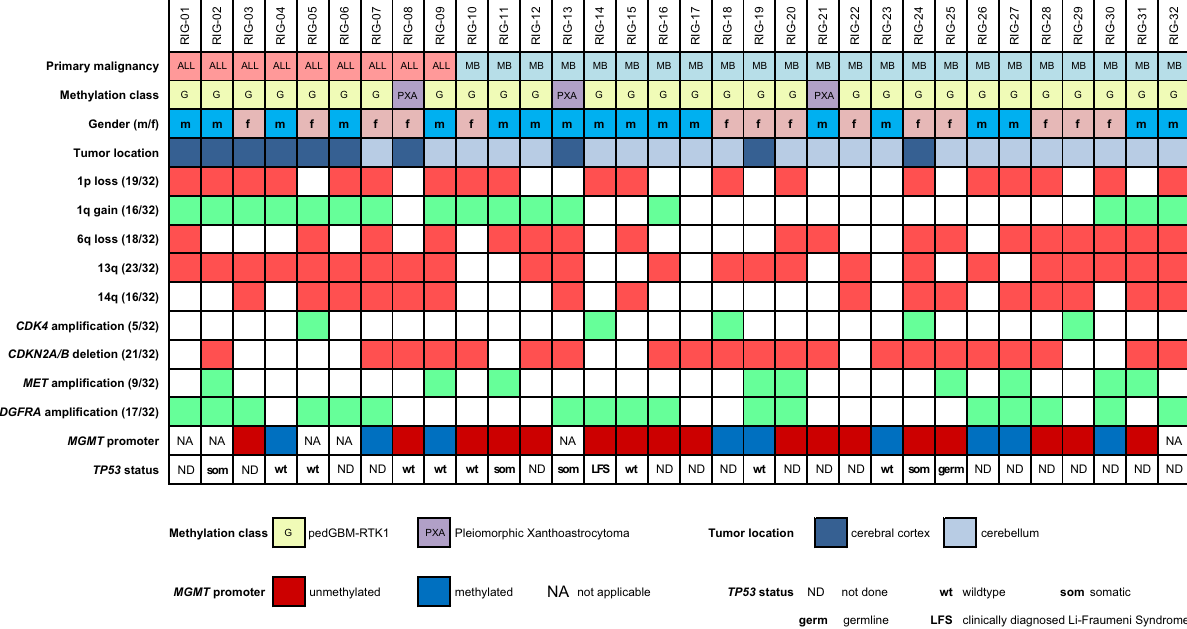
Fig. 5 Oncoplot illustrating the genomic landscape in RIGs. Summary of recurrent, characteristic genetic alterations (focal copy-number alterations, mutations) identi fi ed through DNA methylation arrays and whole-exome/gene panel sequencing. MGMT O6-methylguanine – DNA methyltransferase. ALL acute lymphoblastic leukemia, MB merged to a combined data set by selecting the intersection of probes present on both arrays (combineArrays function, min fi ). Each sample was individually normalized by performing a background correction (shifting of the 5th percentile of negative control probe intensities to 0) and a dye-bias correction (scaling of the mean of normalization control probe intensities to 10,000) for both color channels. Subsequently, a correction for the type of material tissue (FFPE/frozen) and array (450k/EPIC) was performed by fi tting univariate, linear models to the log2- transformed intensity values (removeBatchEffect function, limma package version